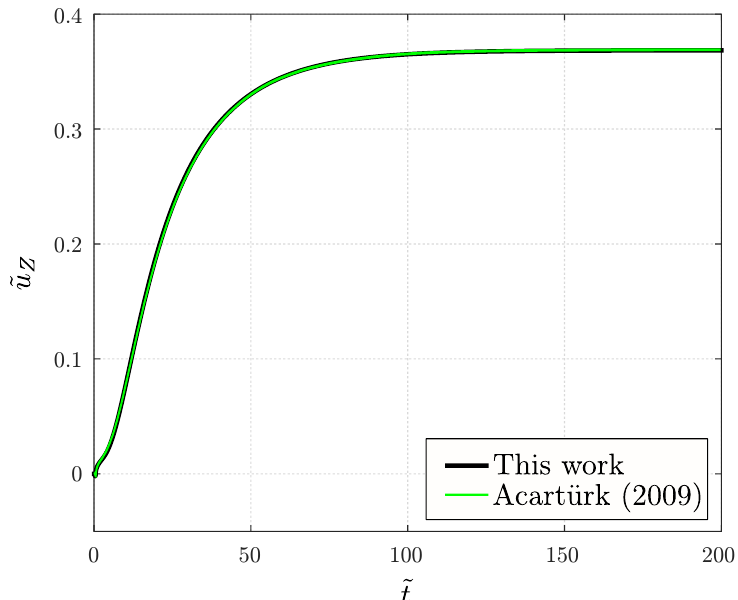
Figure A2. Comparison of the results for the normal displacement of the top surface of the hydro- gel block